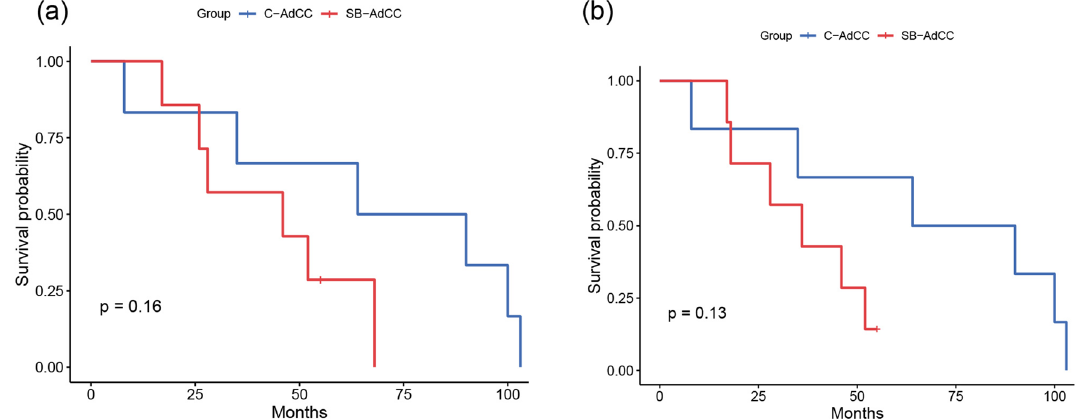
Figure 4. Overall survival ( a ) and disease-free survival analysis ( b ) in classic and solid-basaloid breast